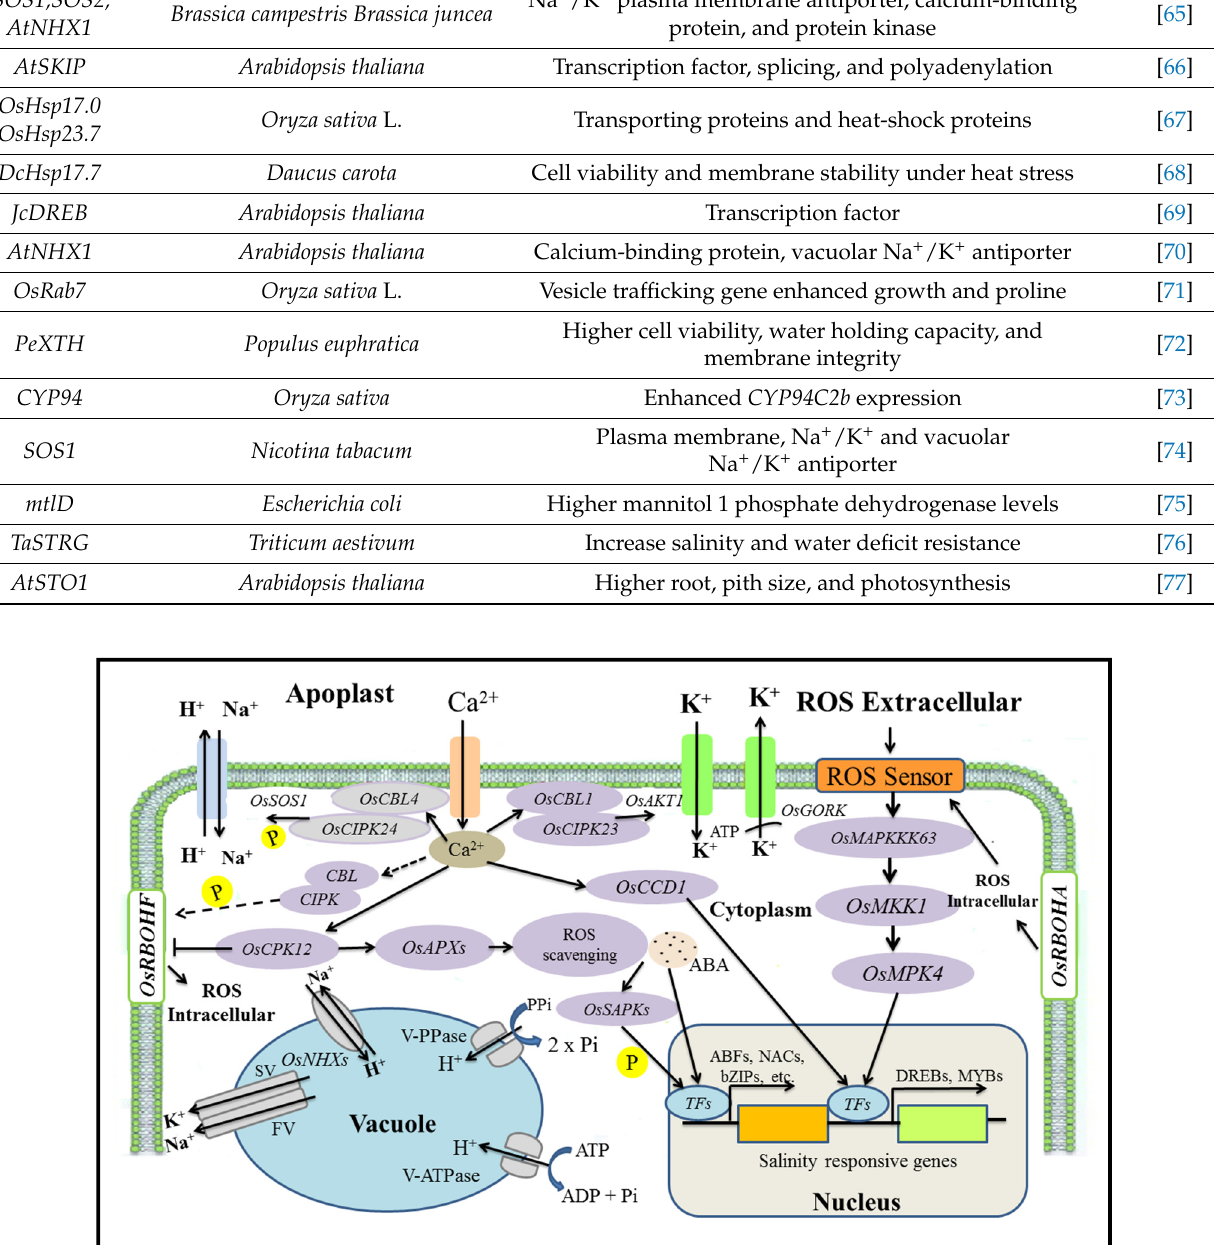
Table 2. Salt responsive genes in various plant species along with their respective gene functions.